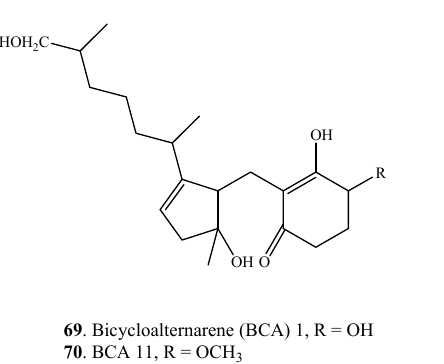
Figure 5. Terpenoids isolated from Alternaria